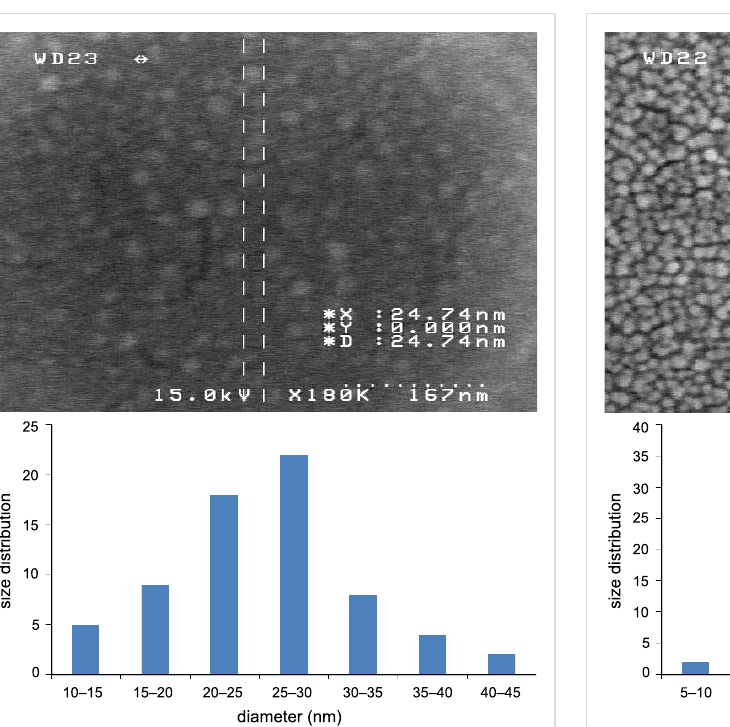
Figure 5: SEM micrograph of compound 3 and histogram indicating the size distribution in the SEM images.